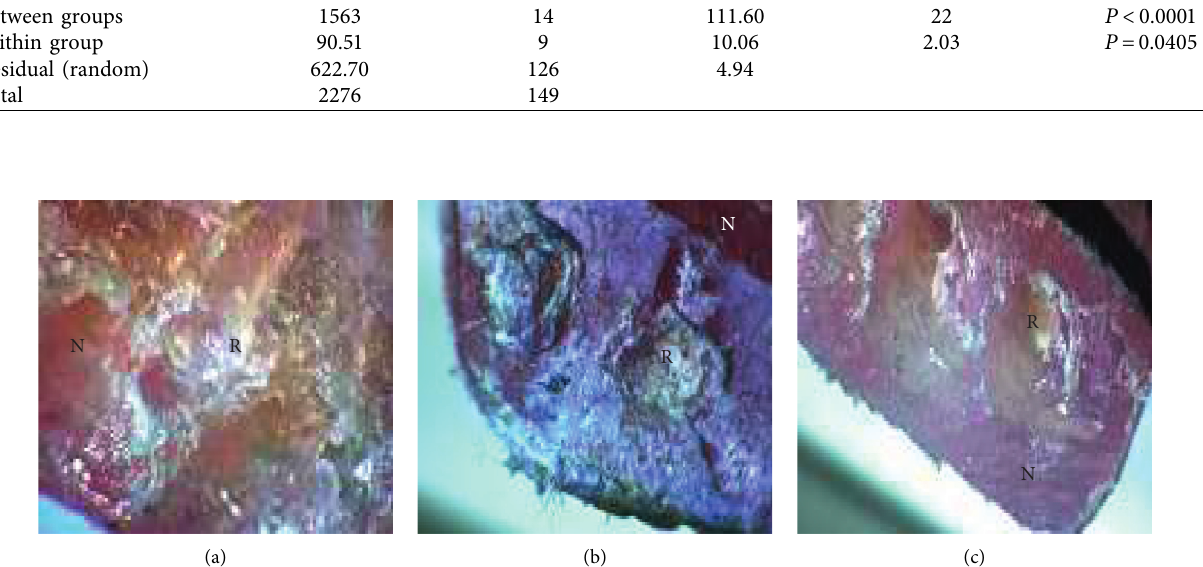
Figure 3: Polarizing microscope images of (a) microwave heat-polymerized, (b) Ivomate autopolymerized, and (c) light-polymerized repaired samples showing the nylon base (N) and the repair materials (R).